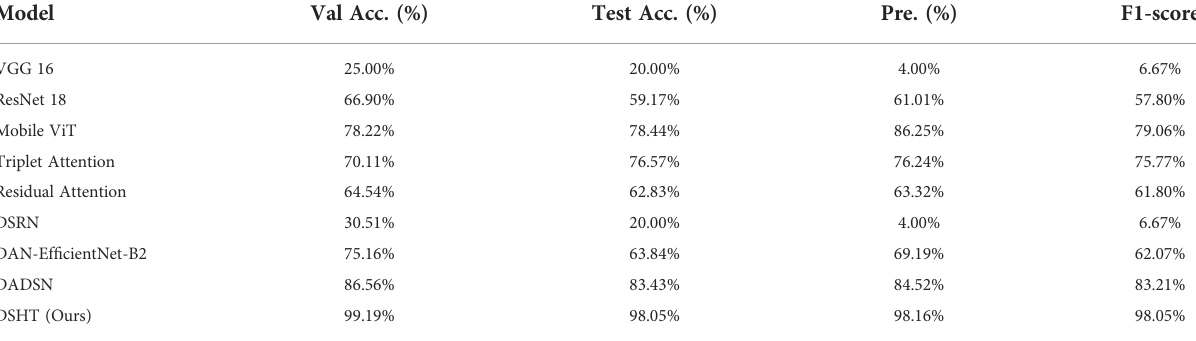
TABLE 4 The Grading